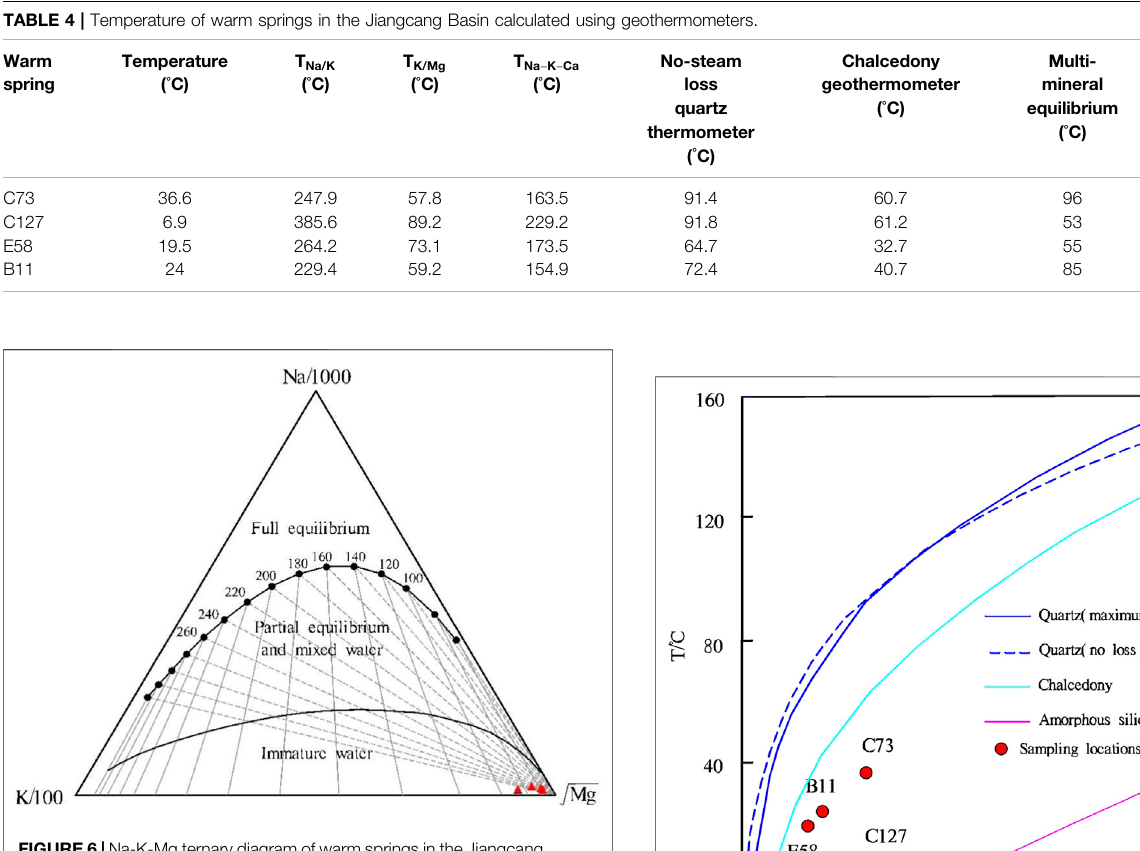
FIGURE 6 | Na-K-Mg ternary diagram of warm springs in the Jiangcang Basin.